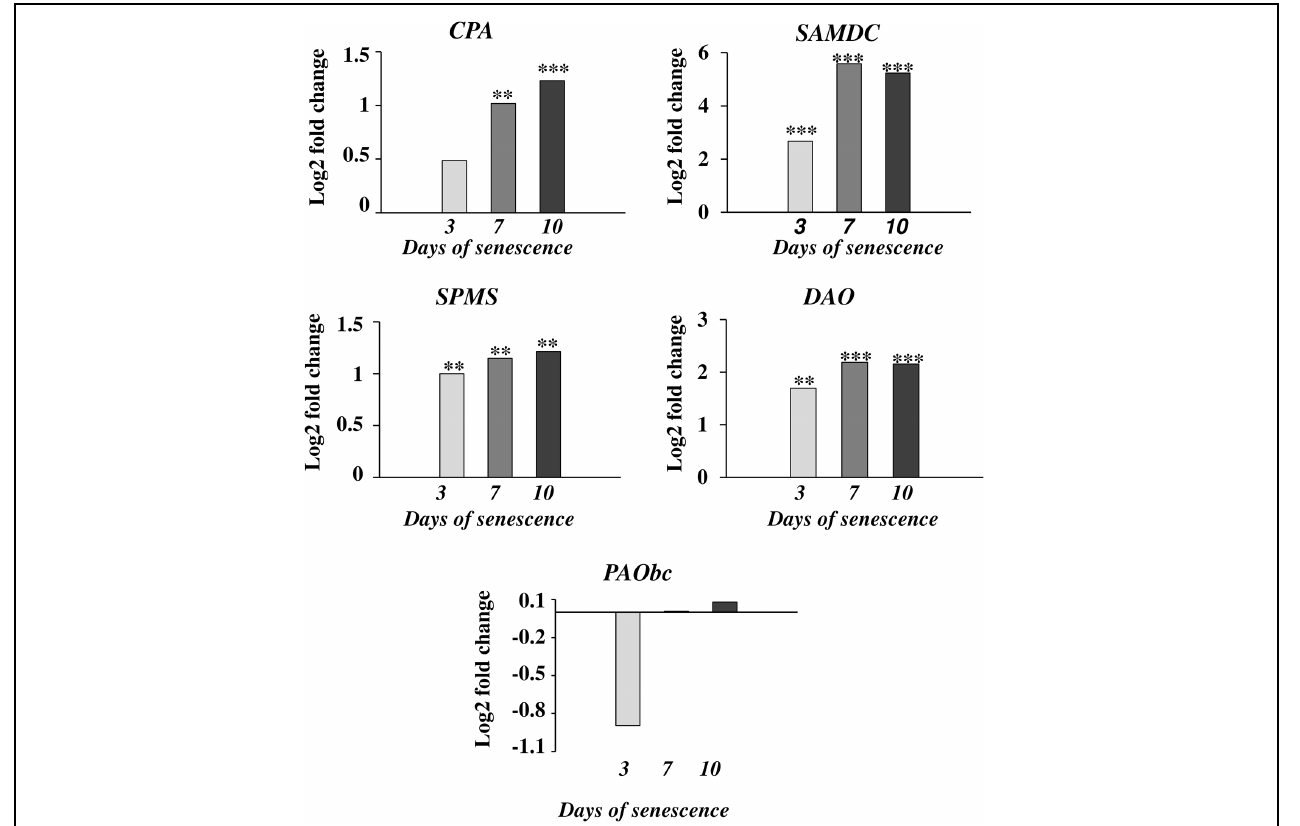
FIGURE 2 | The time course of CPA, SAMDC, SPMS , DAO, and PAObc expression in barley leaves undergoing dark-induced senescence. CPA, N -carbamoylputrescine amidohydrolase; SAMDC, SAM decarboxylase; SPMS, spermine synthase; DAO, diamine oxidase; PAObc, back conversion polyamine oxidase. Barley homologs of each gene were found by homology searches in public databases. The gene expression data are from a time-course experiment performed with an Agilent oligonucleotide microarray (Zmienko et al., 2015a,b). The data are presented as log2-fold changes relative to day 0. Differential gene expression was evaluated with Bayesian linear modeling (R/Bioconductor, limma package) with Benjamini and Hochberg’s correction of the false discovery rate. The adjusted p -values are marked with ∗ p < 0.05, ∗∗ p < 0.005, and ∗∗∗ p < 0.0005.